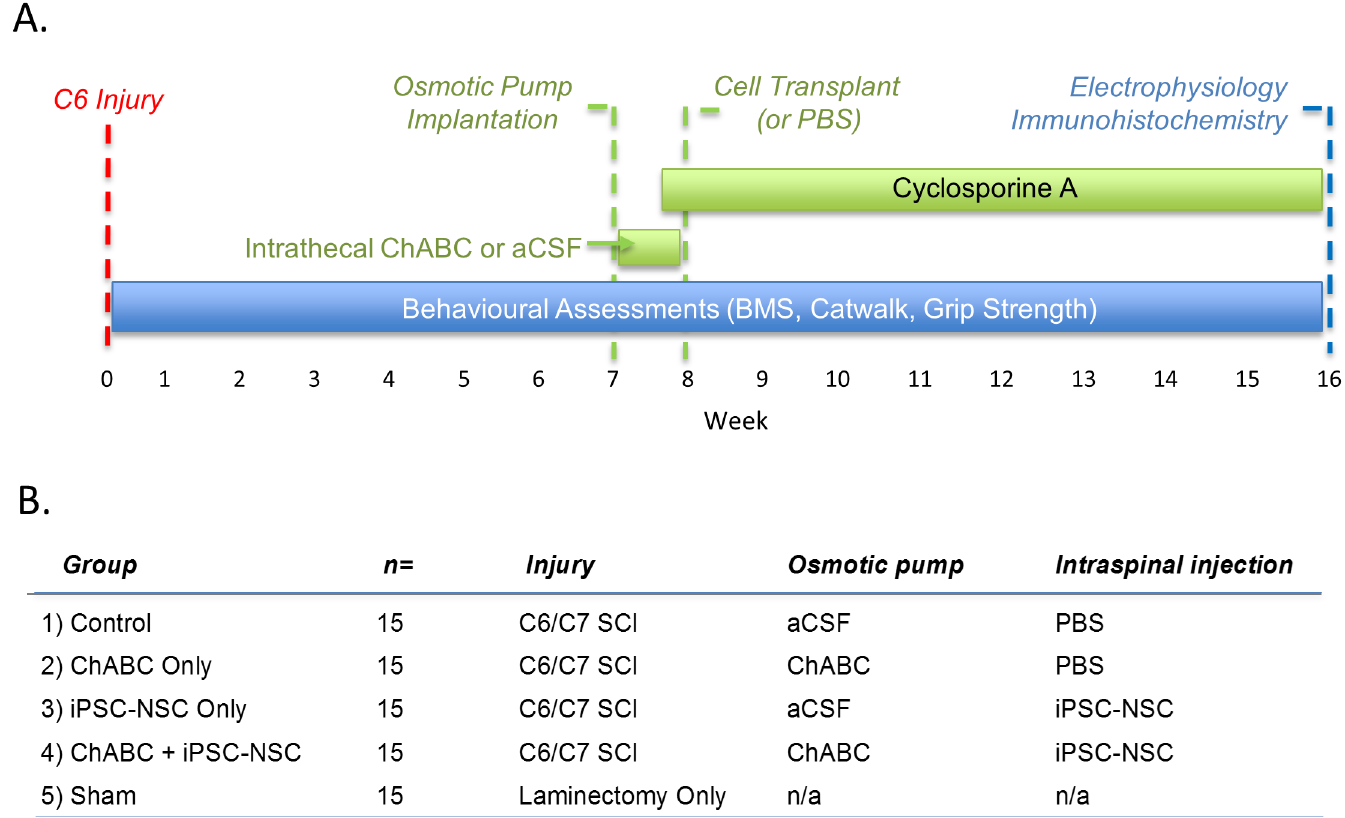
Fig 1. Schematic representation of experimental design. Treatments are in green; assessments are in blue. (A) A C6 clip-contusion spinal cord injury (SCI) was performed at 0 weeks in C57/BL6mice. Seven weeks post-injury, a mini-osmotic pump was implantedrostral to the injurysite. The pump deliveredeither Chondroitinase ABC (ChABC) in artificial cerebral spinal fluid (aCSF) or aCSF alone. One week later the pump was explantedand induced pluripotentstem cell-derivedneuralstem cells (iPS-NSC) were transplantedinto the cord parenchyma at two rostral and two caudal sites. 50,000cells in 1 μ L were delivered to each site. Cyclosporine A immunosuppressionwas delivered from 2 days prior to transplantationuntil the end of the study. Behavioral assessments were performed across all 16 weeks of the study. At 16 weeks electrophysiologicassessments were completedfollowedby whole-animal perfusion, fixation and immunohistochemicalanalyses. (B) Outline of the control and treatment groups. For additionaldetails pleasesee S1